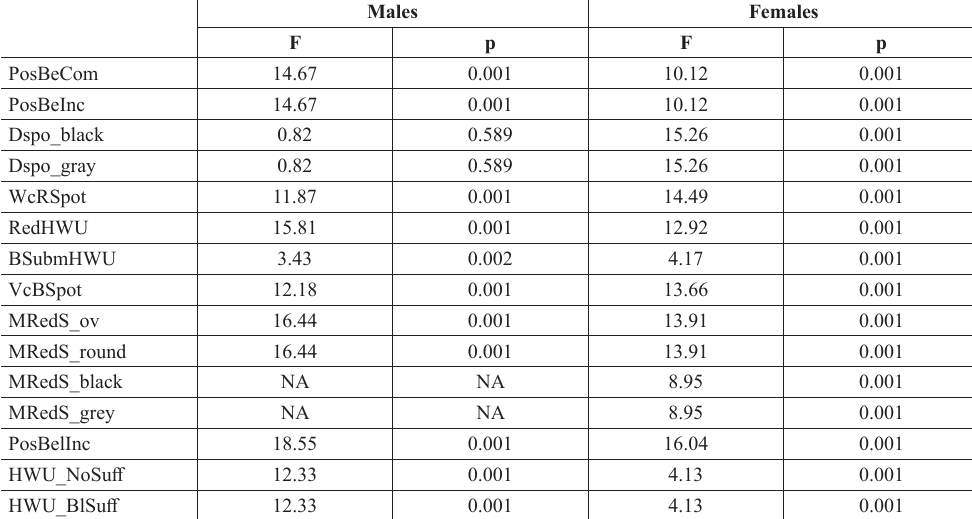
Table 5. Single term tests of wing pattern analyses for males and females of K. charltonius from CCA with 999 Monte Carlo permutations.